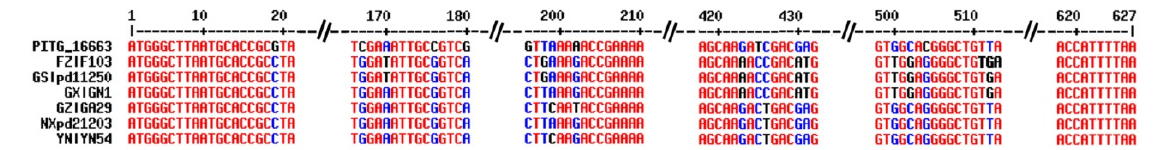
Figure 1. Gene structure and distribution of amino acid diversity in Avr1 . The amino acid diversity was estimated from Avr1 sequences without pre-termination. Note: All abbreviations in the grey box indicate different domains/regions of the Avr1 protein.